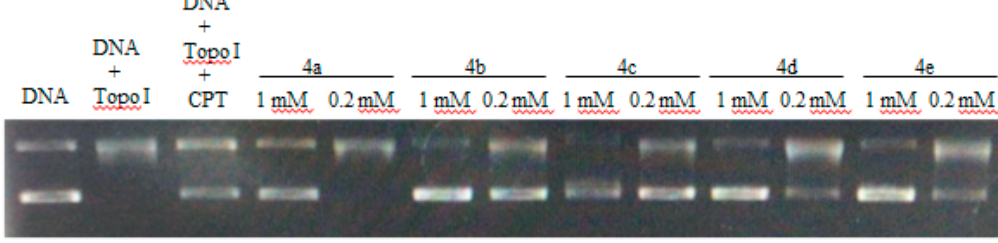
Figure 2. DNA-topo I inhibitory activity of 4a – 4e using camptothecin (CPT) (0.2 mM) as a positive control.